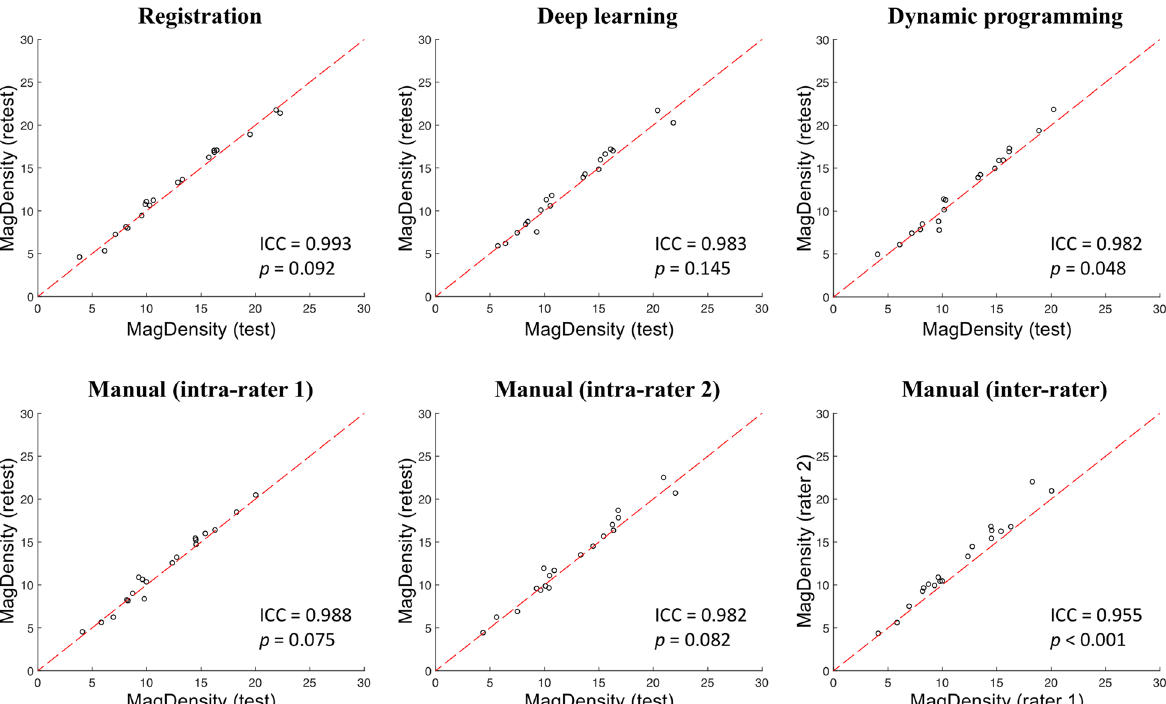
Fig. 5 Plots of test‑retest results of MagDensity derived using different segmentation methods. The red dashed line indicates the line of agreement. The quantitative assessment is shown in Table